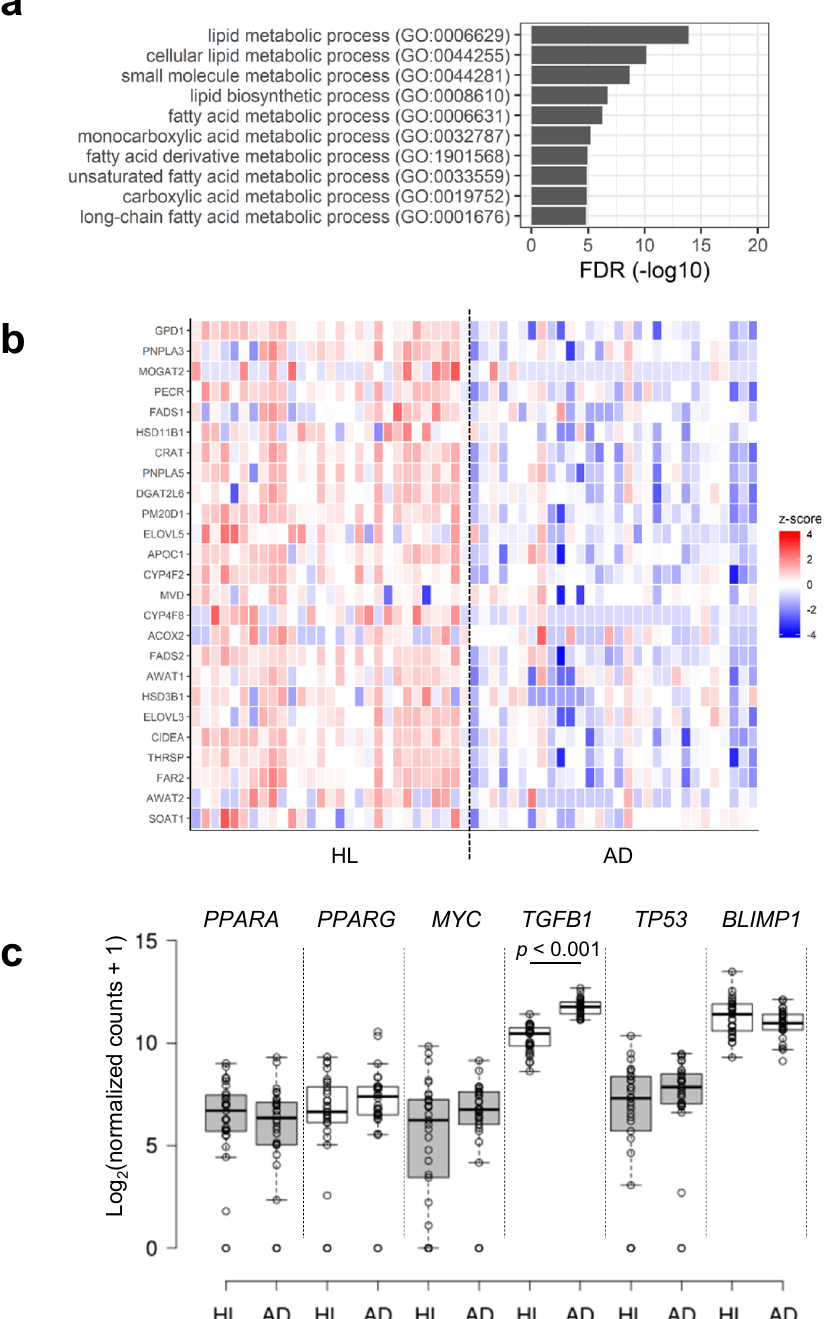
Fig. 7 Comparison of SSL-RNAs pro fi le representing highly expressed genes in sebaceous glands in healthy subjects (HL) and patients with AD. a Gene ontology analysis of 25 genes highly expressed in sebaceous glands (selected in Fig. 4). b Heat maps using z-transformed log 2 (normalized counts + 1) of 25 genes highly expressed in sebaceous glands. c The differential expression of PPARA, PPARG, MYC, TGFB1, TP53 , and BLIMP1 in HL and patients with AD. Boxes represent mean ± interquartile range (IQR), and whiskers represent 1st and 3rd quartile 1.5 * IQR. Benjamini – Hochberg adjusted p - values are shown from the likelihood ratio test between HL and AD. HL ( n = 29), patients with AD ( n =